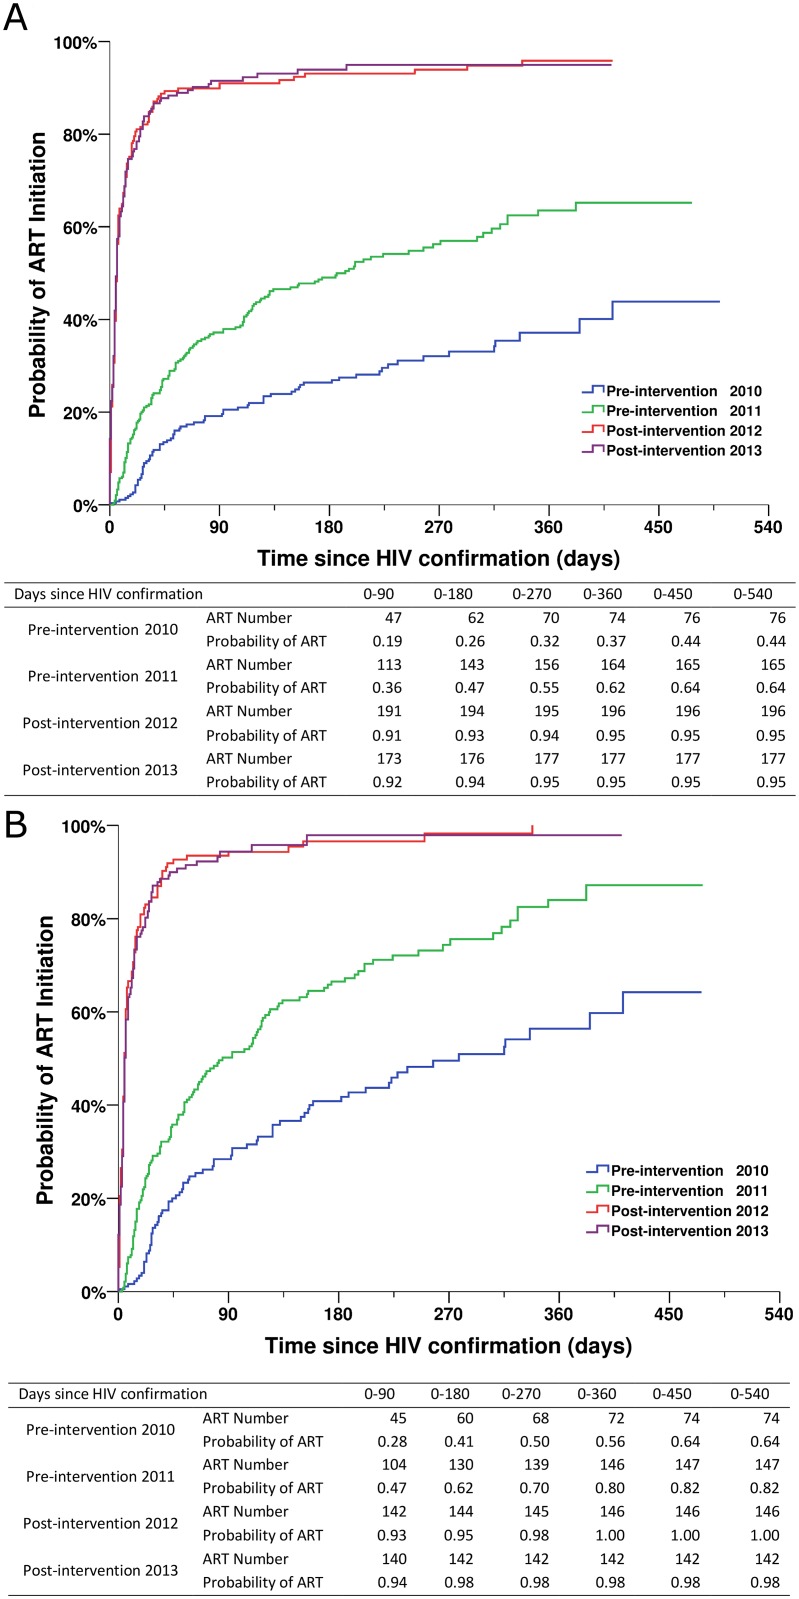
Kaplan-Meier curves for ART initiation for newly diagnosed HIV cases in the pre-intervention 2010, pre-intervention 2011, post-intervention 2012, and post-intervention 2013 phases in Guangxi, China.(A) For all HIV cases. (B) For individuals with CD4 count ≤ 350 cells/mm3 or missing CD4 but reported as AIDS cases.